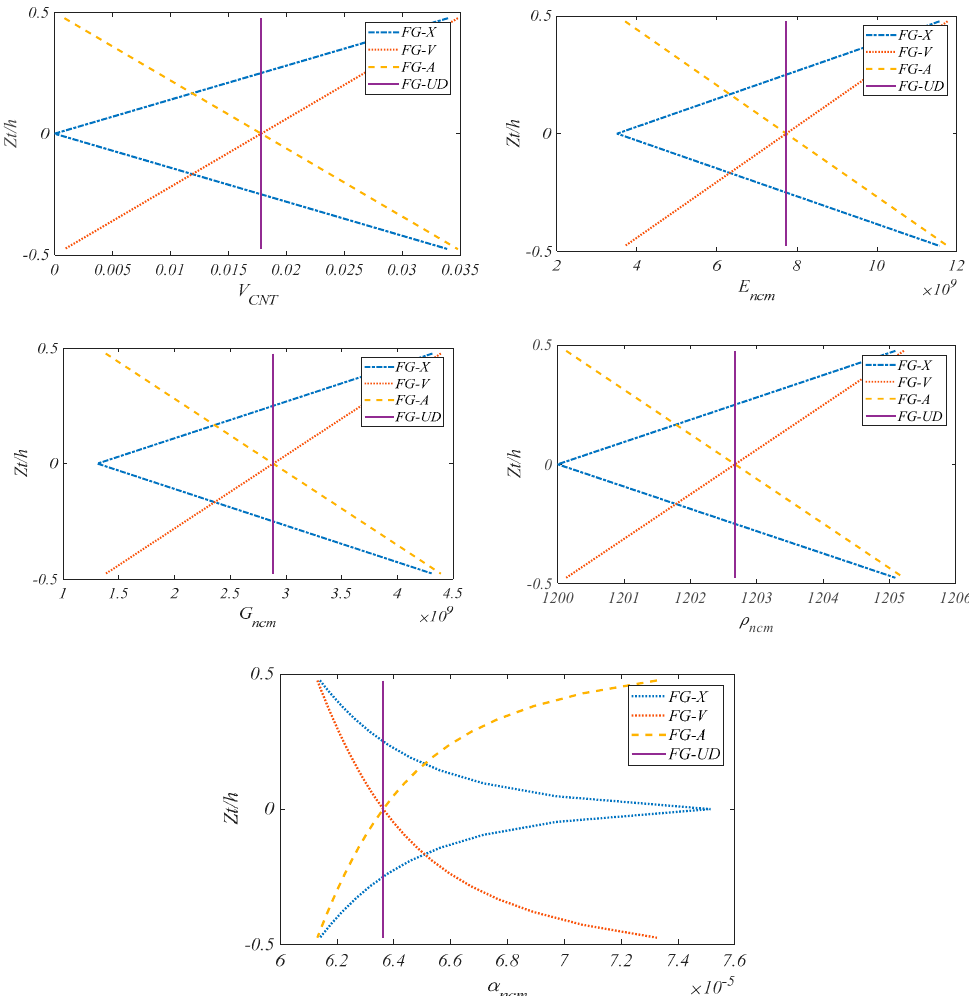
Figure 3. Distribution patterns of carbon nanotube (CNT) through the thickness of the multiscale hybrid annular plate. ( a ) UD; ( b ) FG-X; ( c ) FG-A; ( d ) FG-V. Properties of functionally graded (FG) and uniform distribution of NCM along the thickness direction of the annular plate are displayed in Figure 4 and expressed according to the following relations.